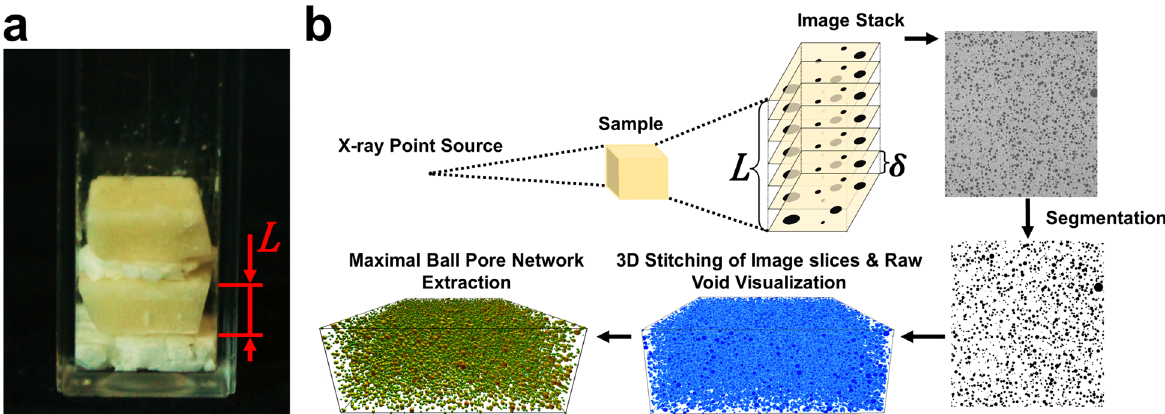
Figure 7. ( a ) A representation of one sample prepared for CT analysis which contains two replicates (with thickness L ) separated by Styrofoam. ( b ) The CT analysis